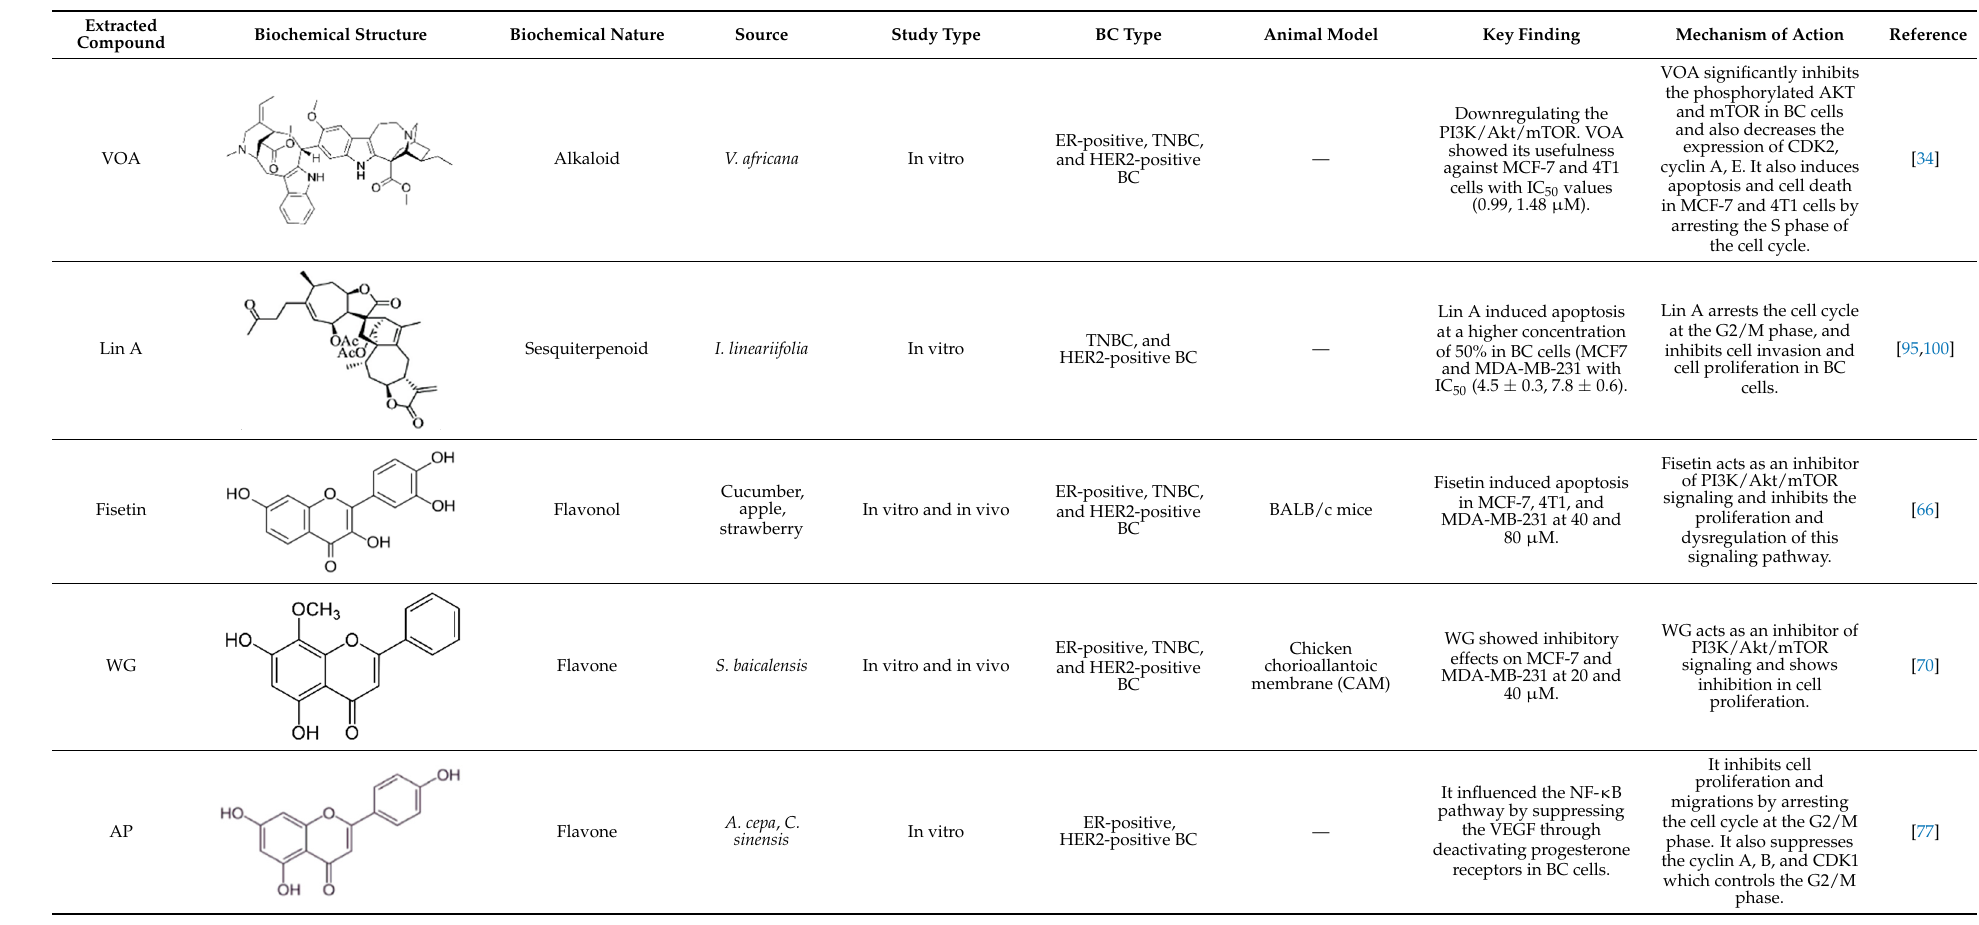
Table 1. The in vitro and in vivo studies on the role of natural products in downregulating the signaling pathways against various types of BC models.